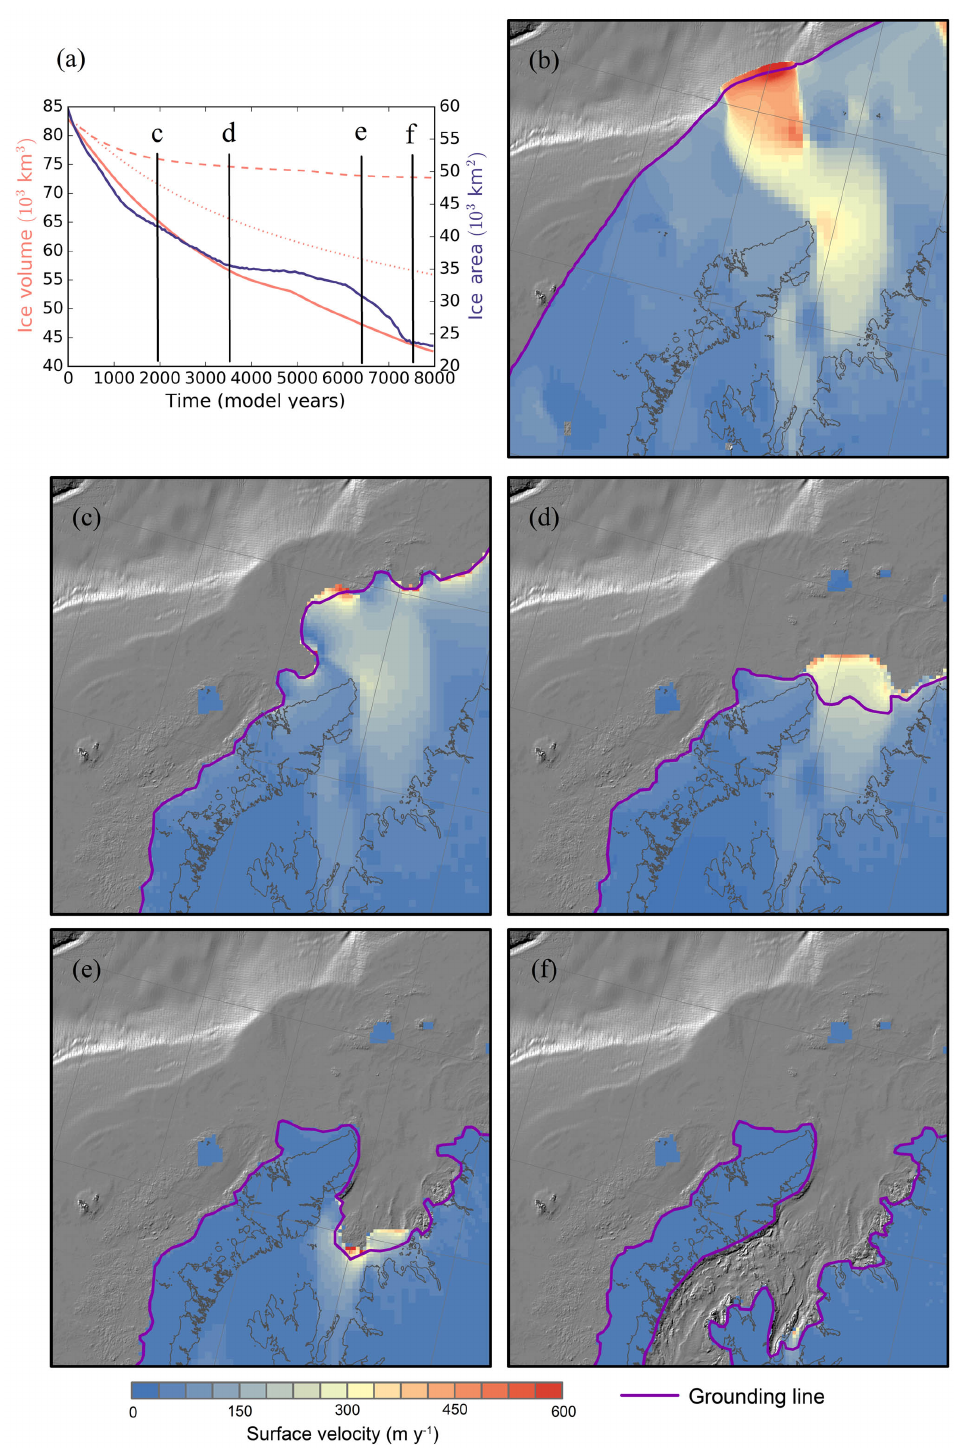
Figure 4. Evolution of the ice sheet in the Minch sector in the RETREAT simulation. The contemporary coast is shown as a thin grey line. (a) Time series of ice volume and area over the Minch sector. The dashed curve shows the volume response to RETREAT_OCN. The dotted curve shows the response to RETREAT_ATMOS. Ice surface velocity (b, c, d, e, f) at 0, 2000, 3500, 6300, and 7500 model years, respectively, with the grounding line shown in